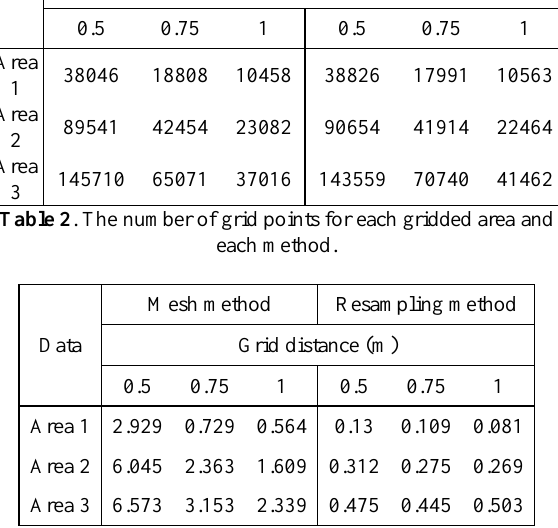
Table 3 . The processing time of the methods (in second).